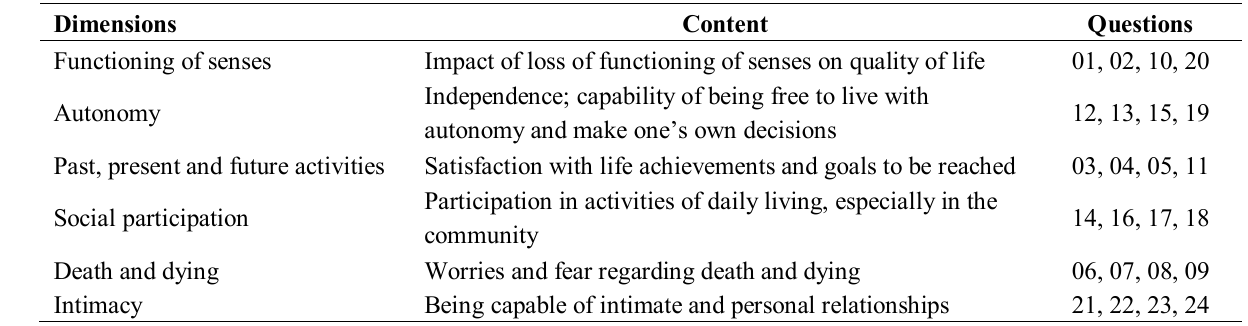
Table 1. Description of dimensions on the